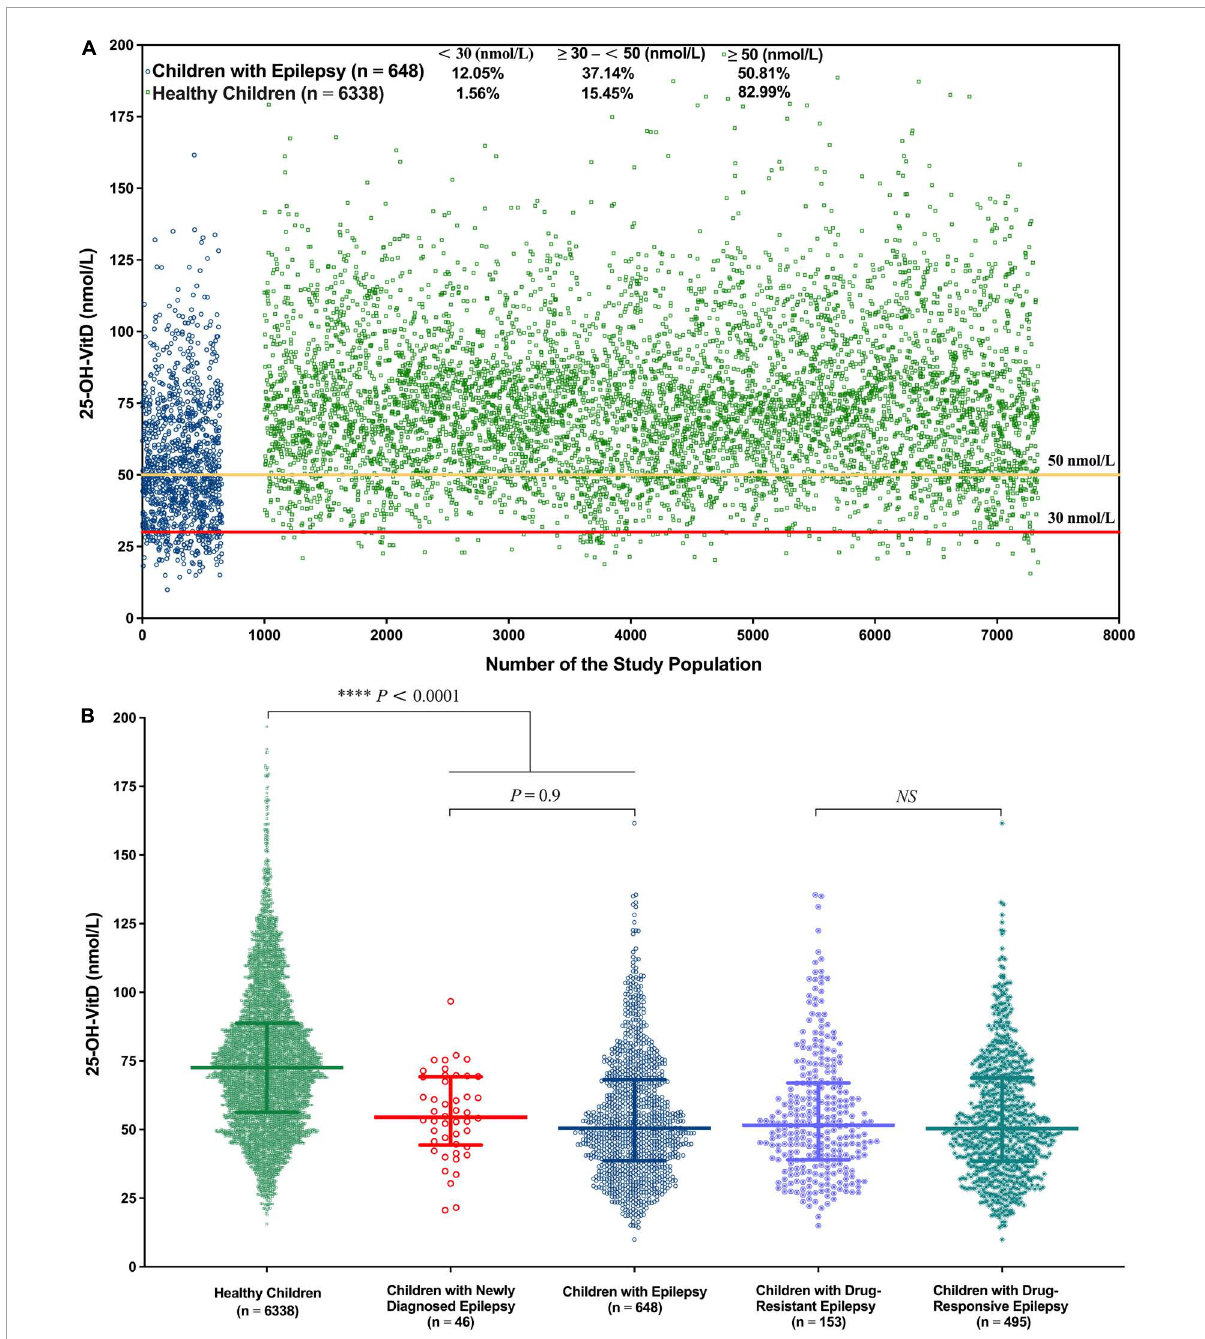
FIGURE2 Overall serum 25-OH-VitD status of 6,338 health children and 648 children with epilepsy. (A) Serum 25-OH-VitD status of 6,338 health children and 648 children with epilepsy and proportion of VitD sufficiency, insufficiency and deficiency. (B) Comparison of healthy children, children with epilepsy, children with newly diagnosed epilepsy (before ASMs treatment), children with drug-resistant epilepsy and children with drug-responsive epilepsy in serum 25-OH-VitD